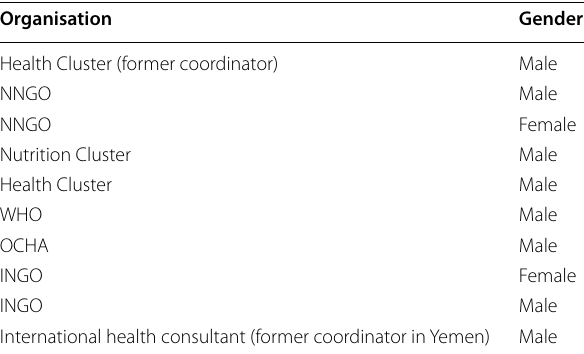
Table 3 Characteristics of the recruited